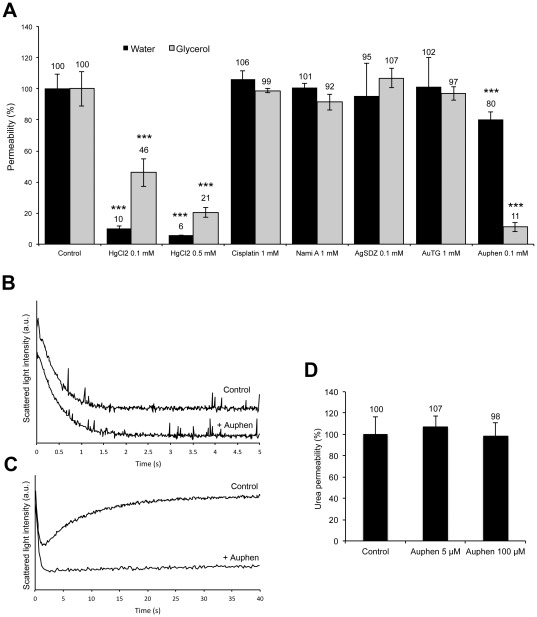
Effect of compounds on hRBC permeability.(A) Water and glycerol permeabilities (% of control) after treatment with the compounds under study and with HgCl2 (10 min at r.t.) A marked effect of Auphen (100 µM) is depicted (***P<0.001). (B) Stopped flow representative traces of water and (C) of glycerol permeability (control and after incubation with 5 µM Auphen, 30 min at r.t.). (D) Urea permeability showing no significant effect of Auphen treatment (5 and 100 µM, 30 min at r.t.; P>0.05).